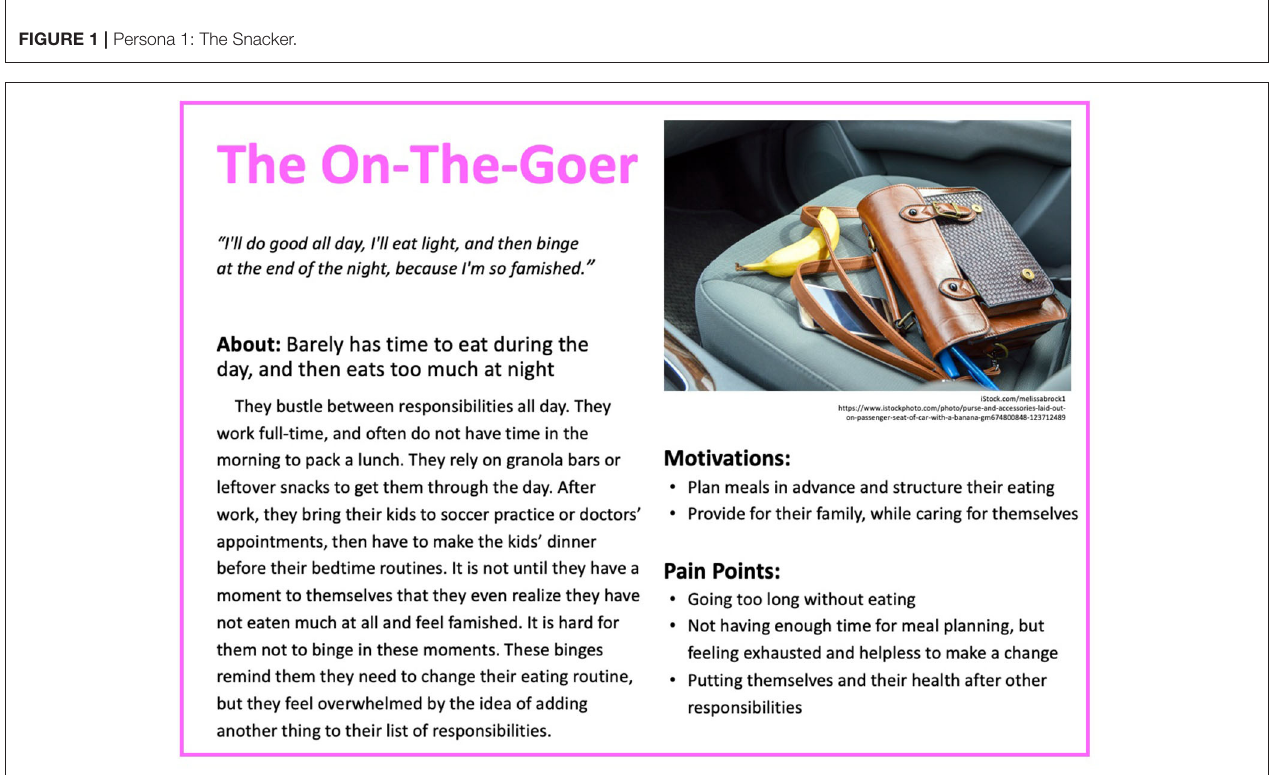
comfort of eating creates a bit of relief, they feel ashamed and guilty after a binge. They do not want people to know that this is their pattern, so they try to hide the evidence of their